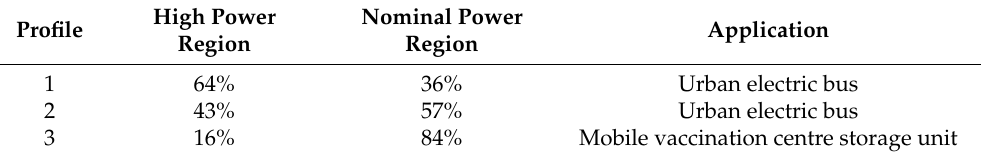
Table 4. Load profile from the active HESS.